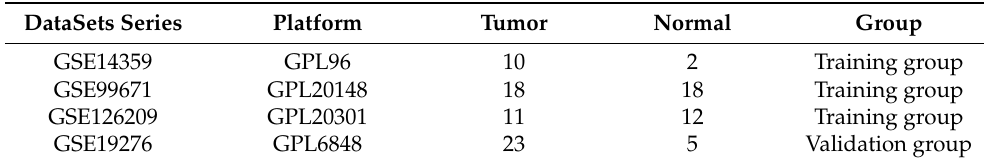
Table 1. The basic information of the Training group and Validation group.